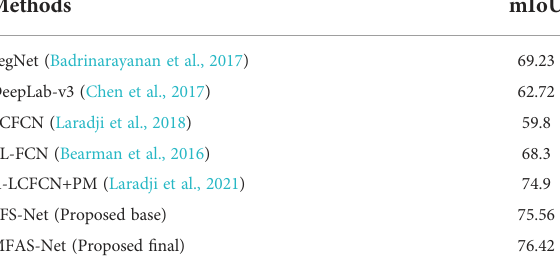
TABLE 5 Comparison between EFS-Net and MFAS-Net ’ s numerical results on the SUIM dataset. Methods